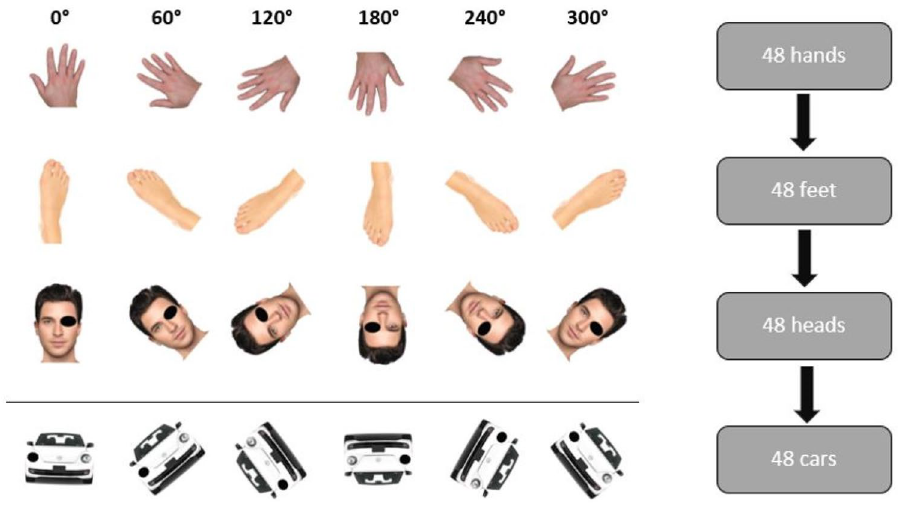
Figure 1. Mental Rotation task: on a screen presented photographs of body parts (in this figure right hands, feet, and heads) and non-corporal objects (here left cars) in different